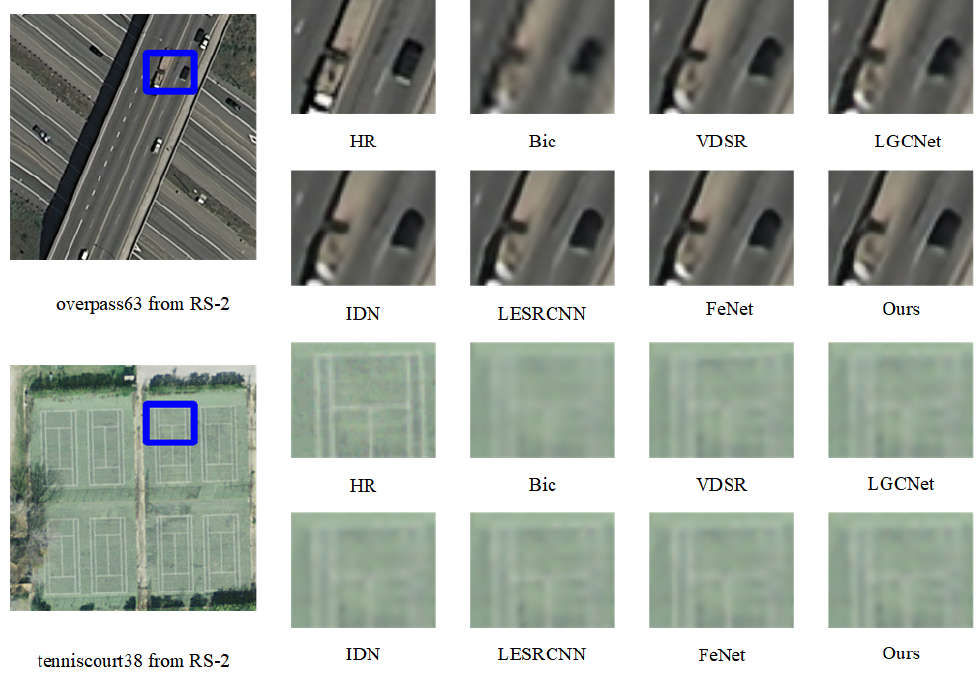
Figure 7. Visualization results of several SR methods and our proposed network, FDENet, on the RS-2 dataset for 3 SR. Zoom in with blue box for best ×